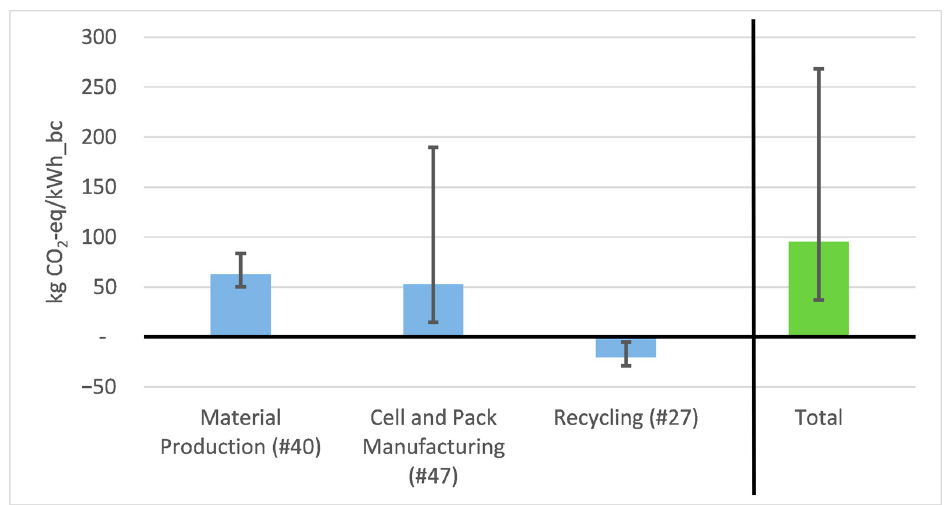
Figure 9. Overall results (results based on median, 25%-quantile, and